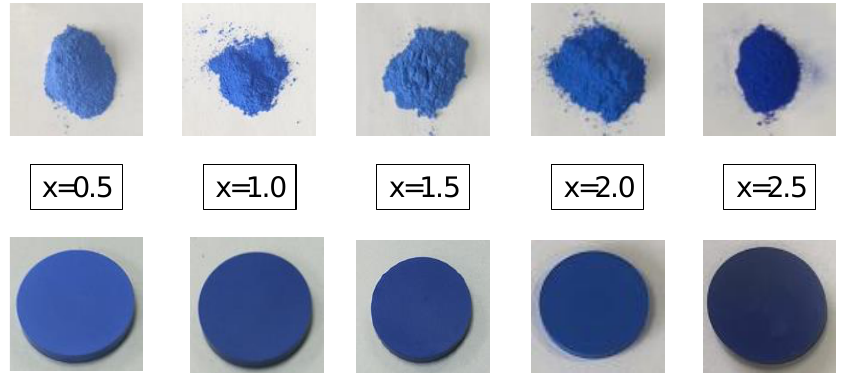
Figure 5. The chromaticity change curves of different Mg-based lanthanum hexaaluminate samples with different Co contents prepared at 1450 °C.